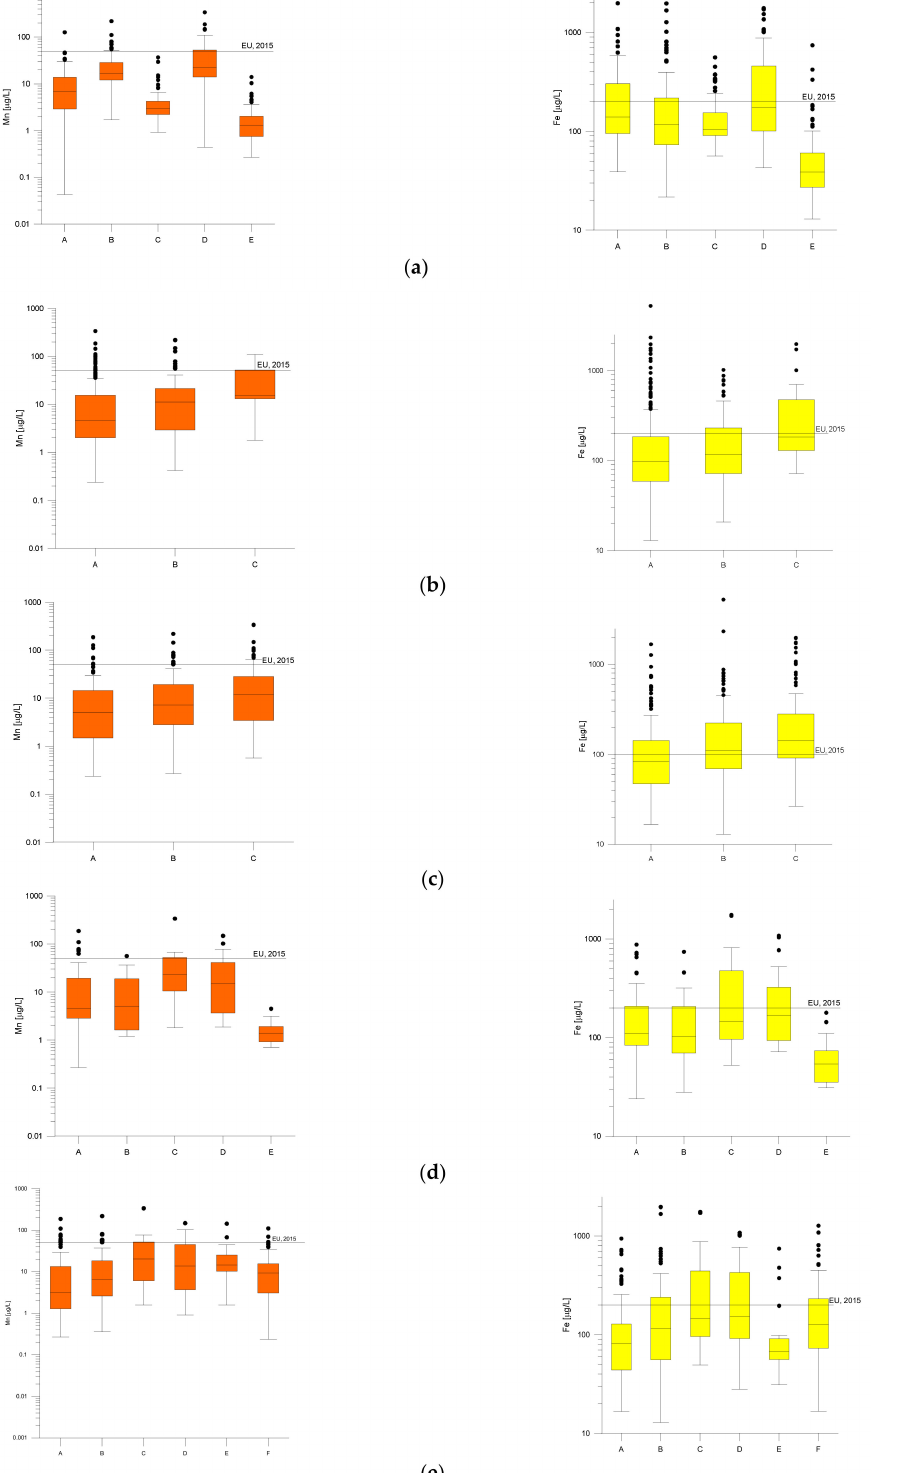
Figure 2. Fe and Mn concentrations in the water analysed by selected categories of factors. ( a ) City: A, Krakow; B, Jaworzno; C, Kamienna Gora; D, Raciborz; E, Myszkow. ( b ) Age of tap: A, <10 years; B, 10–30 years; C, >30 years. ( c ) Age of pipe-work: A, <10 years; B, 10–30 years; C, >30 years. ( d ) Material of connection: A, PCV; B, steel; C, galvanised steel; D, stainless steel; E, other. ( e ) Material of pipe-work: A, PCV; B, steel; C, galvanised steel; D, stainless steel; E, copper; F,